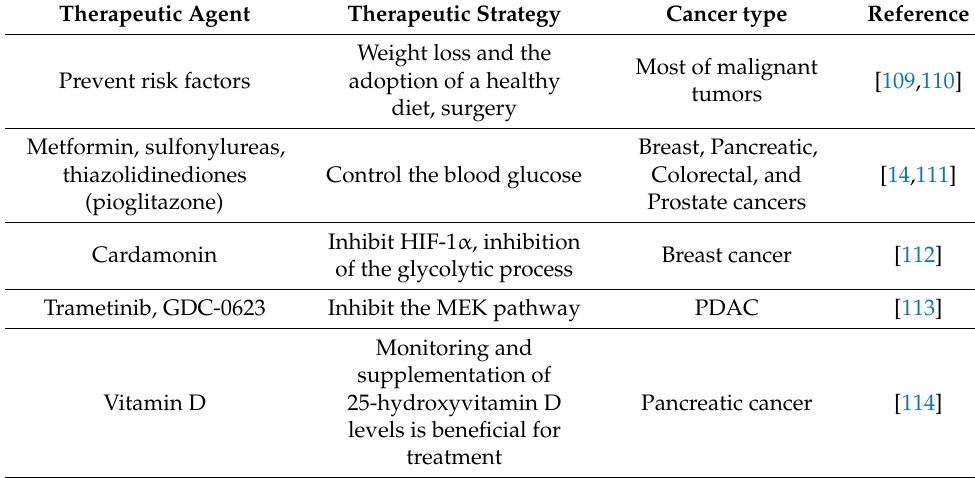
Table 1. Therapeutic strategies targeting